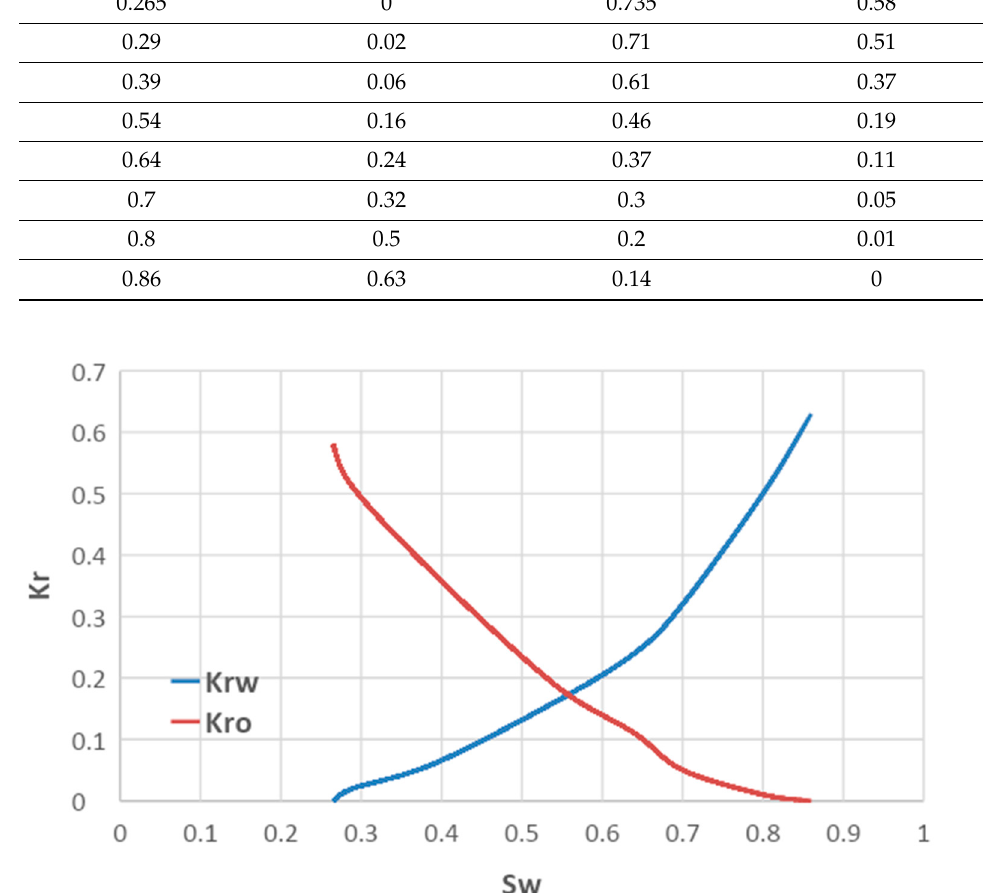
Figure A1. Relative permeability and water saturation plot for a sandstone core sample.